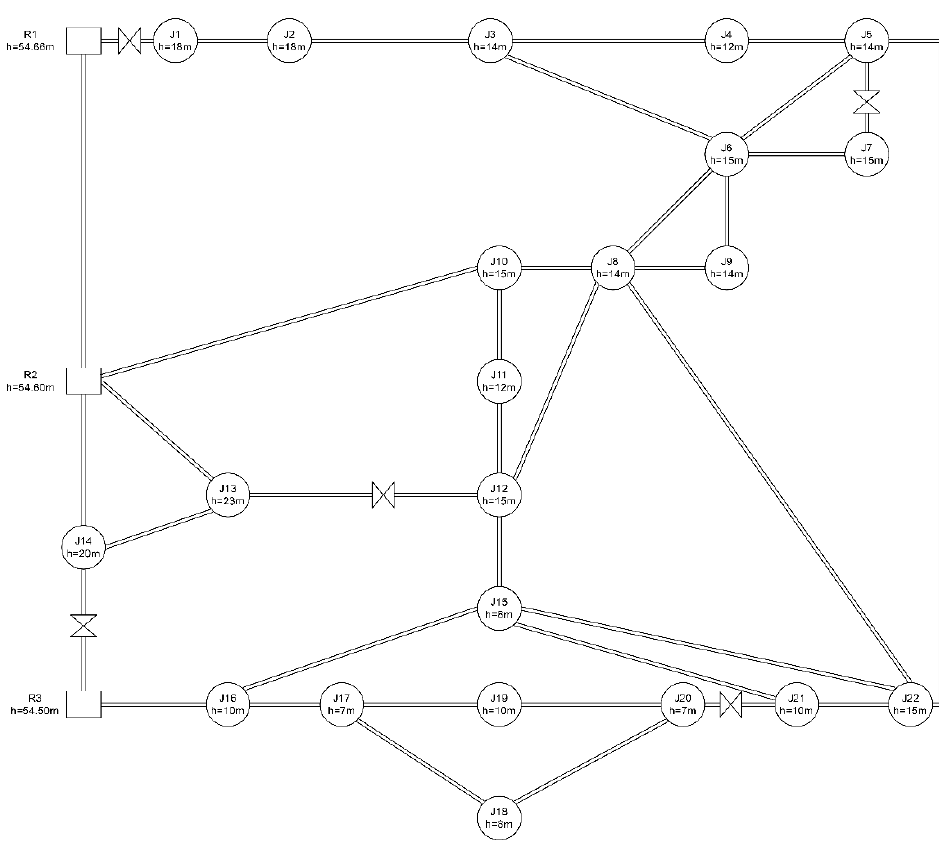
Table 3. The optimization model.